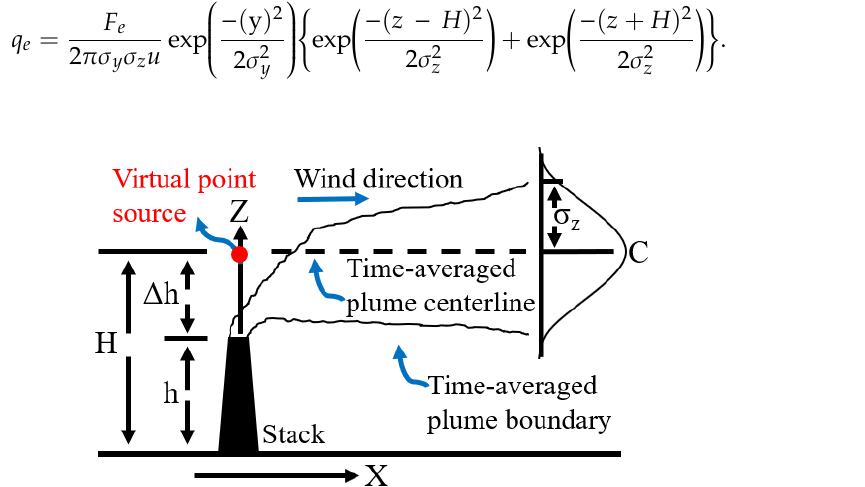
Figure 3. Schematic representation of the Gaussian plume model utilized to retrieve the mixing ratio of NH 3 ( g ) in the exhaust stack from the values measured 1 m NH 3 (g) in the exhaust stack from the values measured 1 m above.